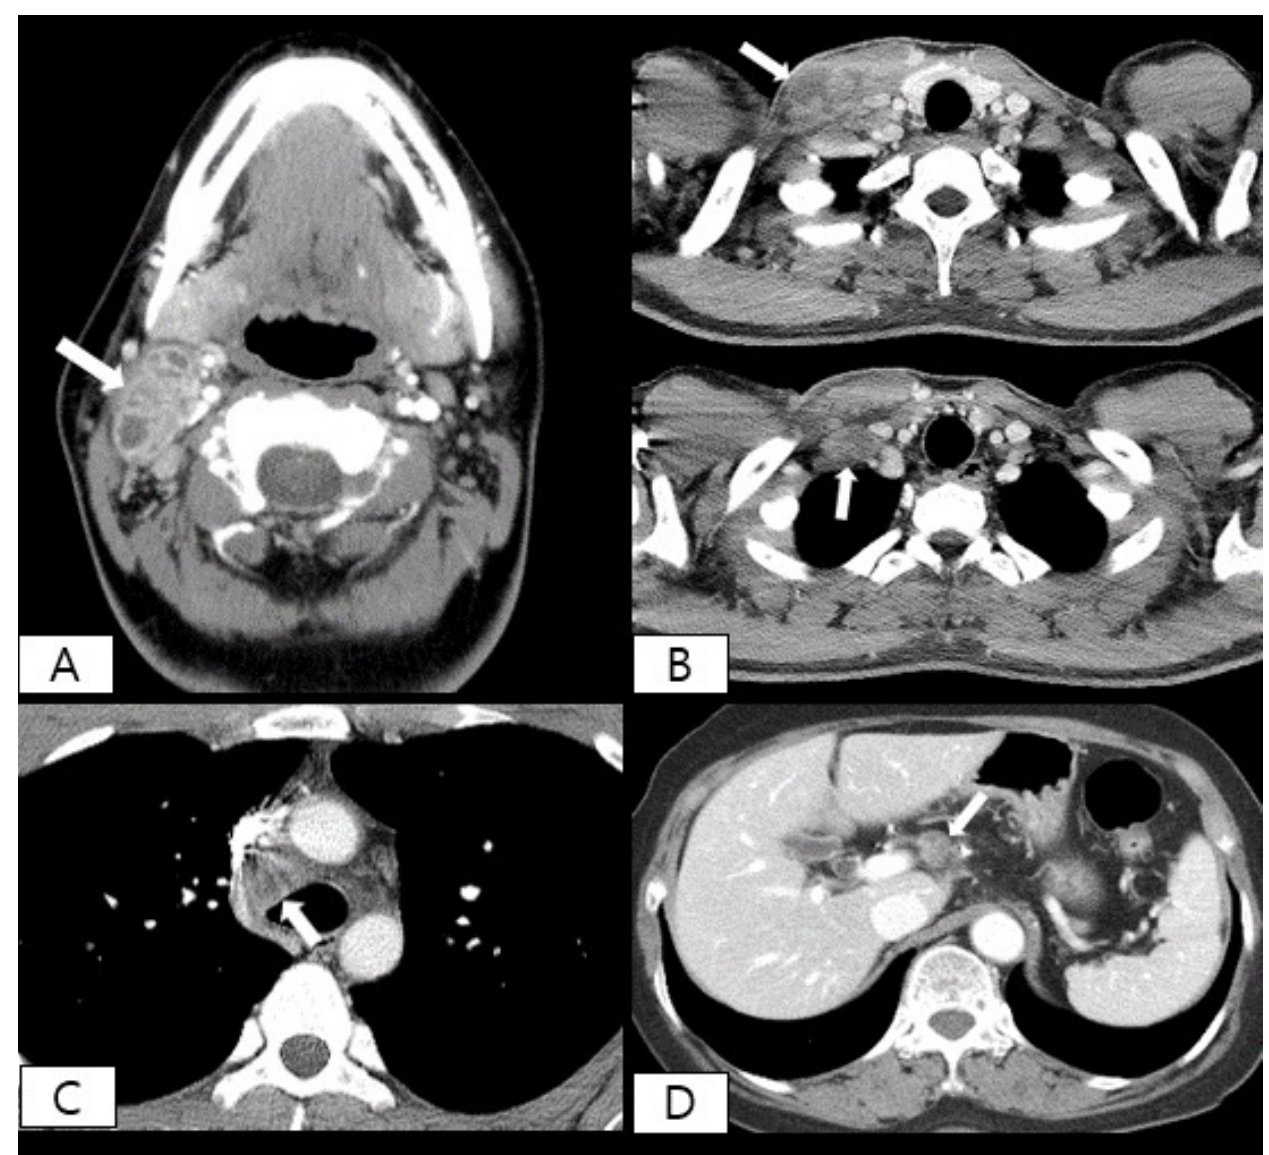
Figure 1. Post-contrast computed tomography (CT) images of four representative cases of pathologically proven tuberculous lymphadenitis. ( A ) Neck CT scan of 19-year-old female patient shows multiple conglomerated lymph nodes in level II on the right side of neck. Enlarged lymph nodes show peripheral rim enhancement and central necrosis (arrow). ( B ) Neck CT scan of 23-year-old male patient shows enlarged lymph nodes with necrosis (arrows) in level IV on the right side of neck (upper panel) and supraclavicular space (lower panel). ( C ) Chest CT scan of 31-year-old female patient shows enlarged lower paratracheal lymph nodes on the right (arrow). ( D ) Abdominal CT scan of 72-year-old female patient shows multiple enlarged lymph nodes in gastrohepatic ligament area (arrow). Table 3. TB antigen stimulated marker levels according to clinico-radiological features of TB-LAP patients. Pulmonary Tuberculosis *